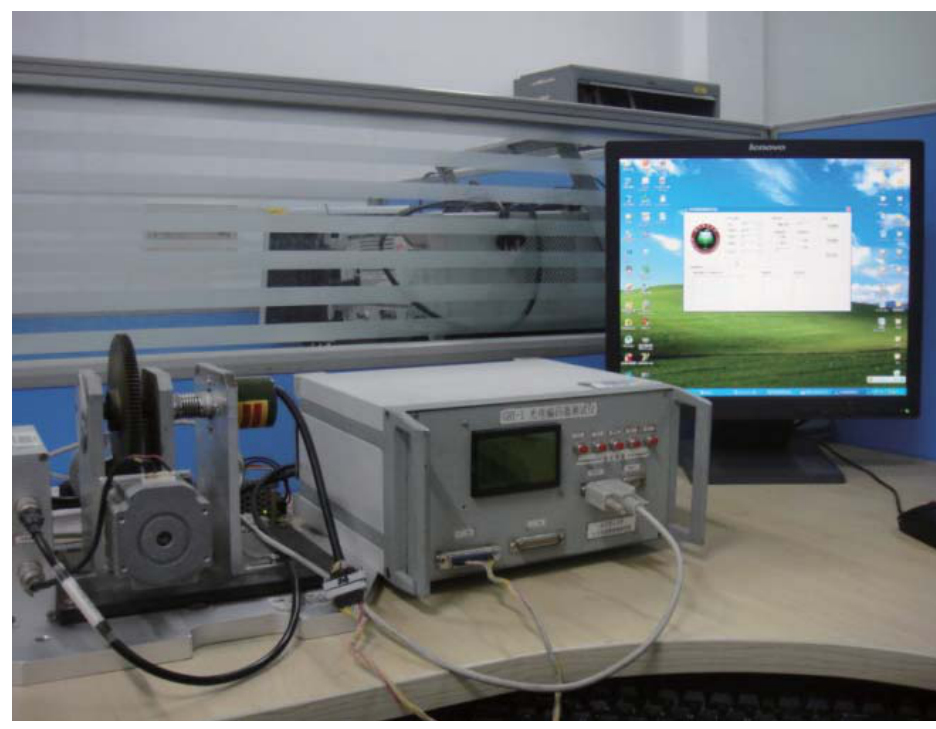
Figure 6. The details of the general